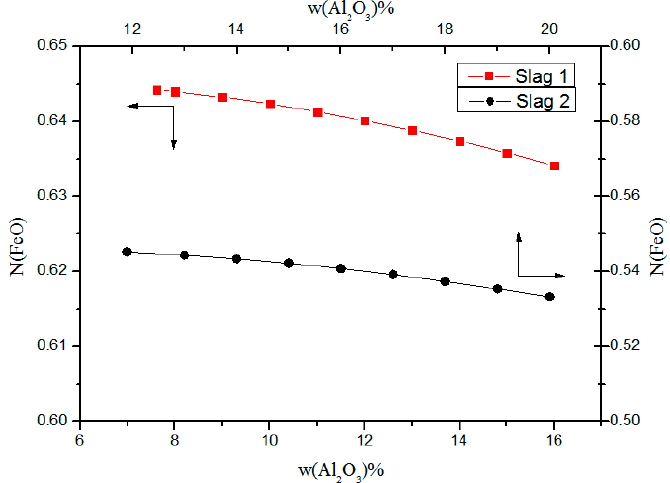
Figure 7. Effect of Al 2 O 3 on activity of FeO.